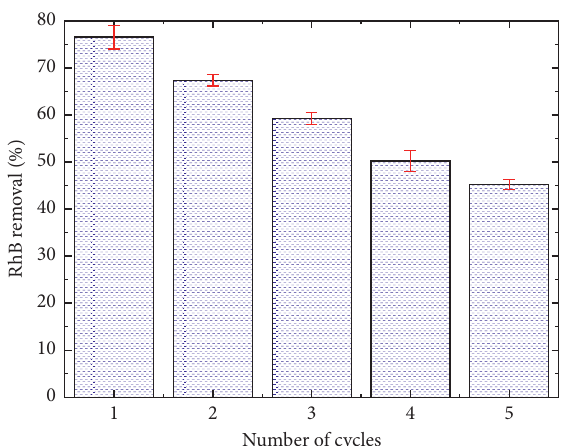
Figure 12: RhB adsorption efficiency of CAC/CoFe adsorption/desorption